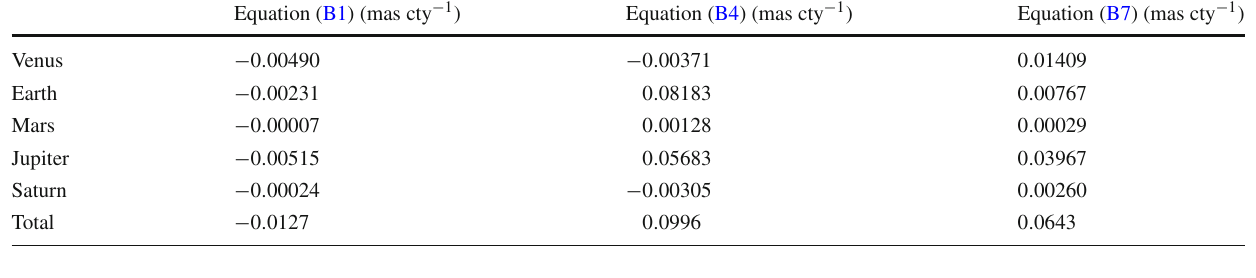
Table 2 Doubly averaged 1pN third-body perihelion precessions of Mercury, in mas cty − 1 , induced by Venus, Earth, Mars, Jupiter, Sat- urn via Eqs. (B1)–(B7). The resulting total precession amounts to